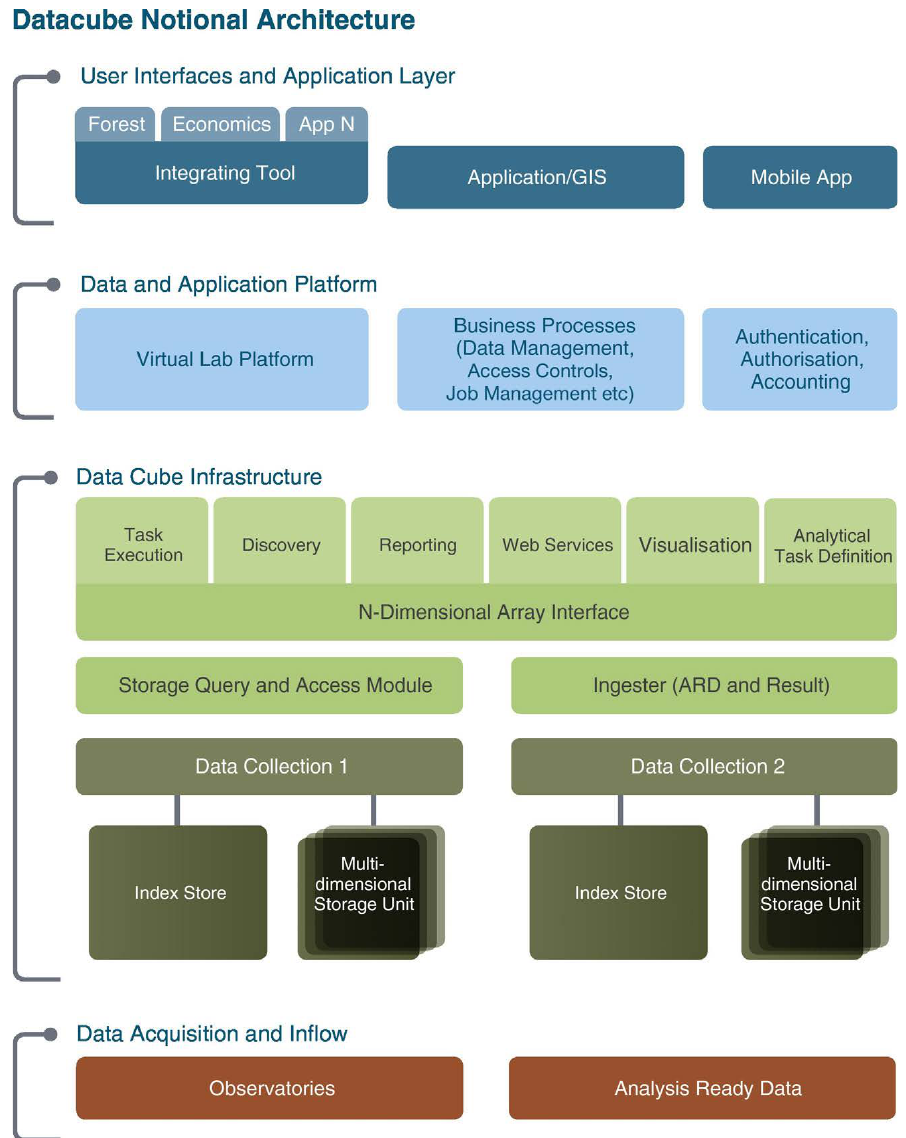
Figure 3. Architecture diagram of the Open Data Cube (ODC) platform. Source: Lewis et al.